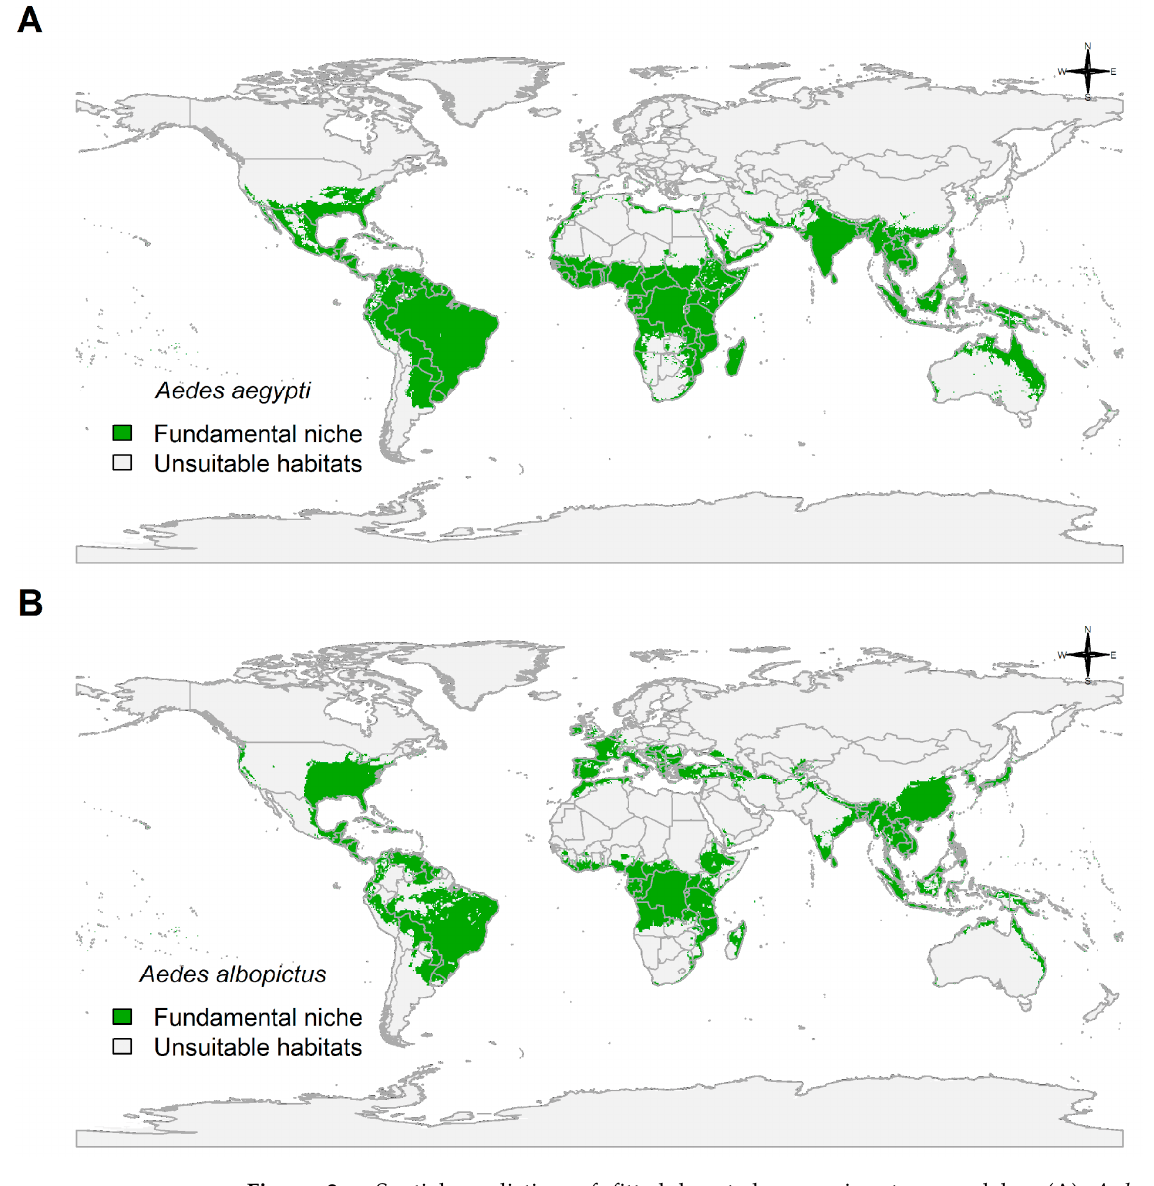
Figure 2. Spatial prediction of fitted boosted regression tree models: ( A ) Aedes aegypti (model evaluation: AUC = 0.9946303; threshold of maximum sensitivity + specificity = 0.8452035); and ( B ) Aedes albopictus (model evaluation: AUC = 0.9996303; threshold of maximum sensitivity + specificity = 0.9944801). Fundamental niche = predicted probability of presence > threshold; unsuitable habitats = otherwise. World country map was based on simplified world country polygons by NASA.